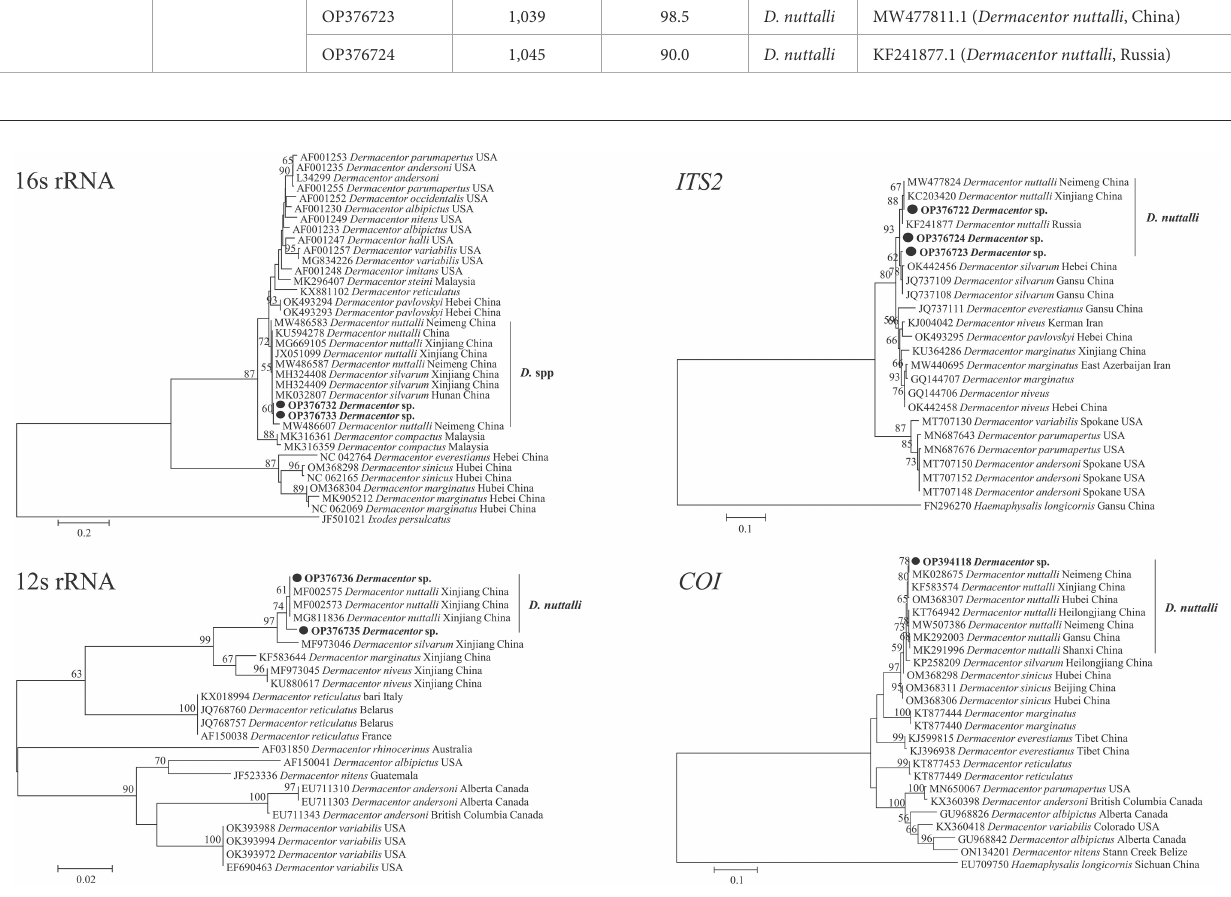
FIGURE3 Molecular phylogenetic analysis by the maximum likelihood method based on the 12S rRNA, 16S rRNA, COI , and ITS2 genes of D. nuttalli . The sequences obtained in this study are shown in bold font. The numbers at the nodes represent bootstrap support values.